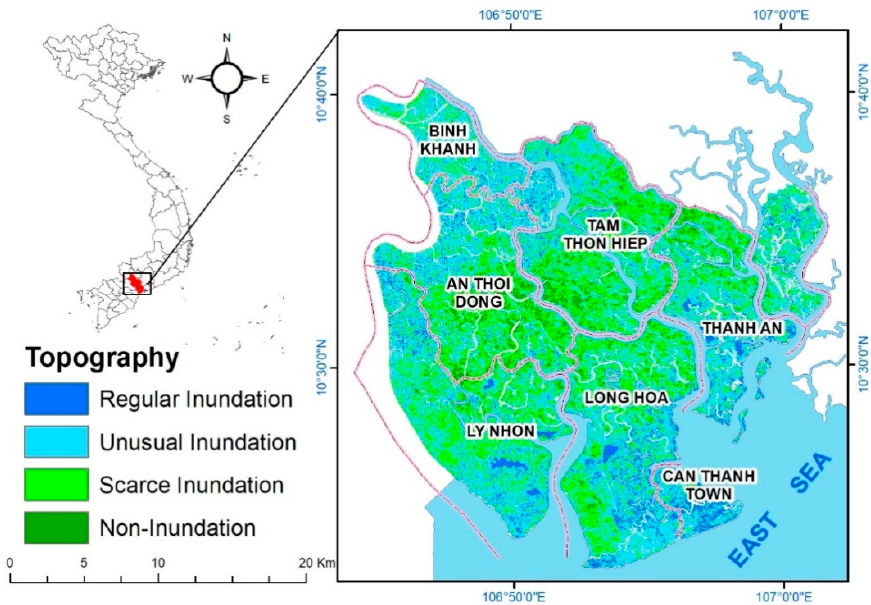
Figure 1. Location and zone ranges of elevation in study area.